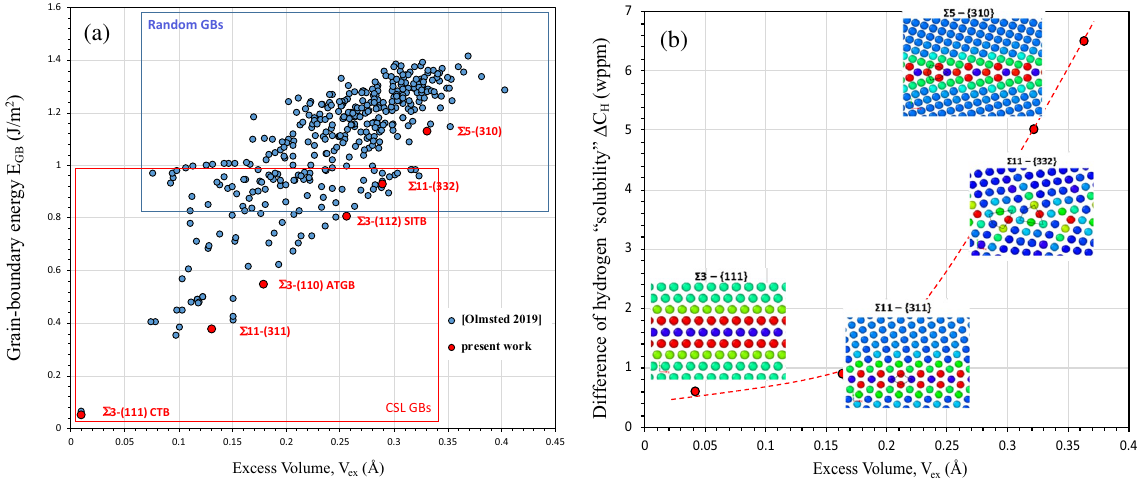
Figure 2. ( a ) Grain-boundaries energy E GB versus the excess volume V ex (data from atomistic calculations courtesy to Olmsted et al. 64 ). The grains boundaries studies in present work are represented in the picture with red dots. Our calculation has been performed with the same atomic potential. ( b ) the difference of hydrogen solubility ΔC H between single crystal and bi-crystal with the same hydrogen ingress orientation as a function with the grain boundary excess volume V ex (ΔC H are collected by experimental works, V ex is determined numerically using atomistic